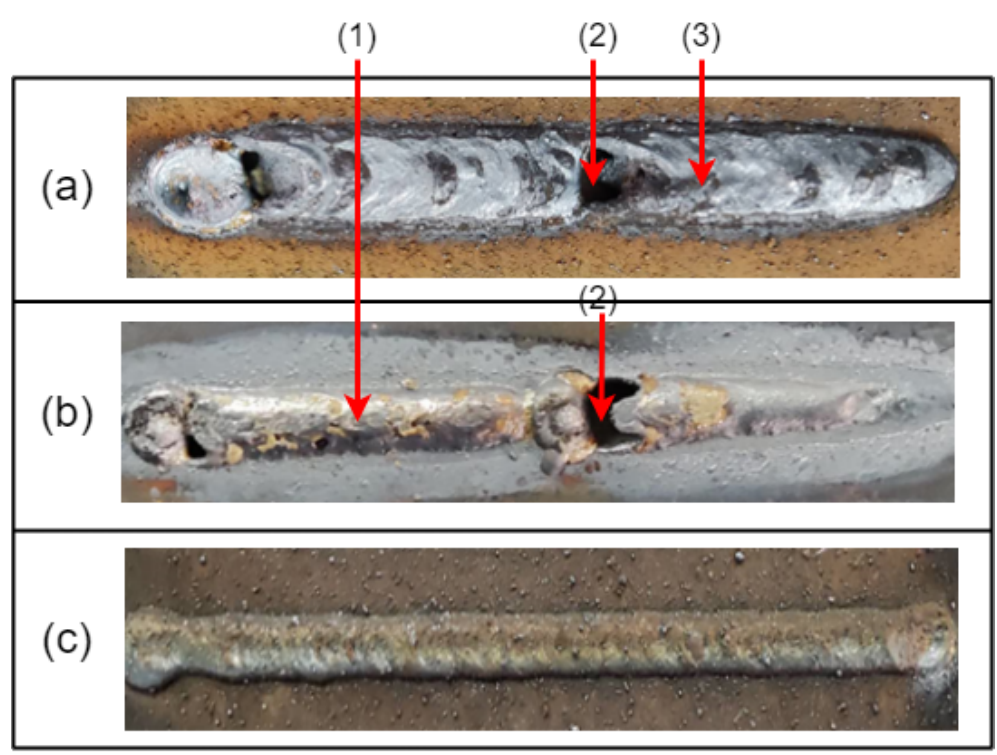
Figure 4. Weld images: ( a ) Front face of weld with obvious welding defects; ( b ) back side of weld with obvious welding defects; ( c ) welds without obvious welding defects. ( 1 ) Excessive penetration, ( 2 ) burn-through, and ( 3 )